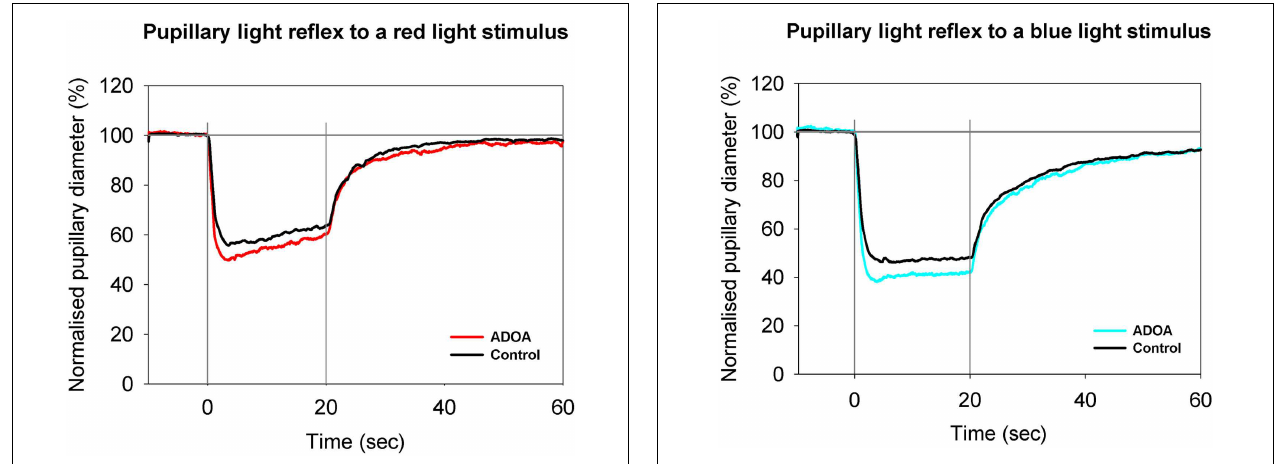
FIGURE 1 | Pupillary contraction to a red light stimulus (660nm) as a function of time (s) . A constant and continuous stimulus of 300cd/m 2 was applied at time 0 (first vertical gray line) and discontinued at the end of the 20th second (second vertical gray line).The stimulus was applied to one eye and the consensual, pupillary contraction of the other eye recorded.The red graph represents the mean of contractions set off by stimulation in ADOA eyes, and the black the mean of contractions set off by stimulation in control eyes. During light stimulation, contraction is larger in the red graph than in the black graph.When the light stimulus is terminated, fairly rapid re-dilatation ensues. No statistically significant difference is detected (cf. Table 2 ).The red graph shows the mean value from 29 subjects suffering from ADOA, the black graph the mean of 40 healthy control eyes.The AUC is the area between the horizontal line: NPD = 100% and the graph in question.